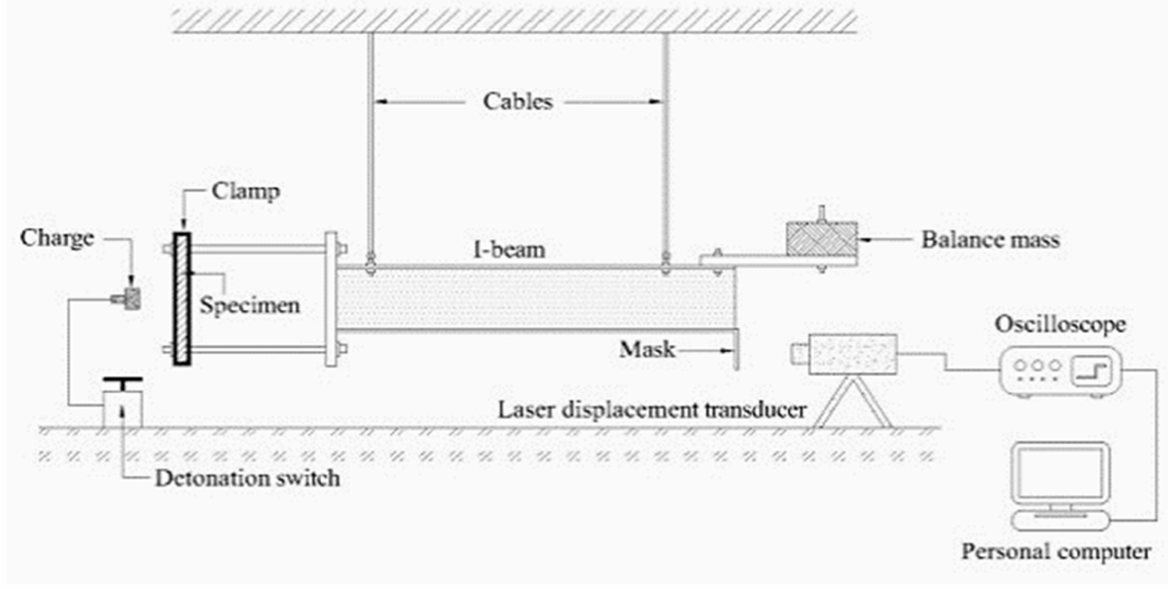
Figure 8. A schematic view of a four-pendulum bar mechanism for material characterization of a fiber metal laminate composite under impulsive loading